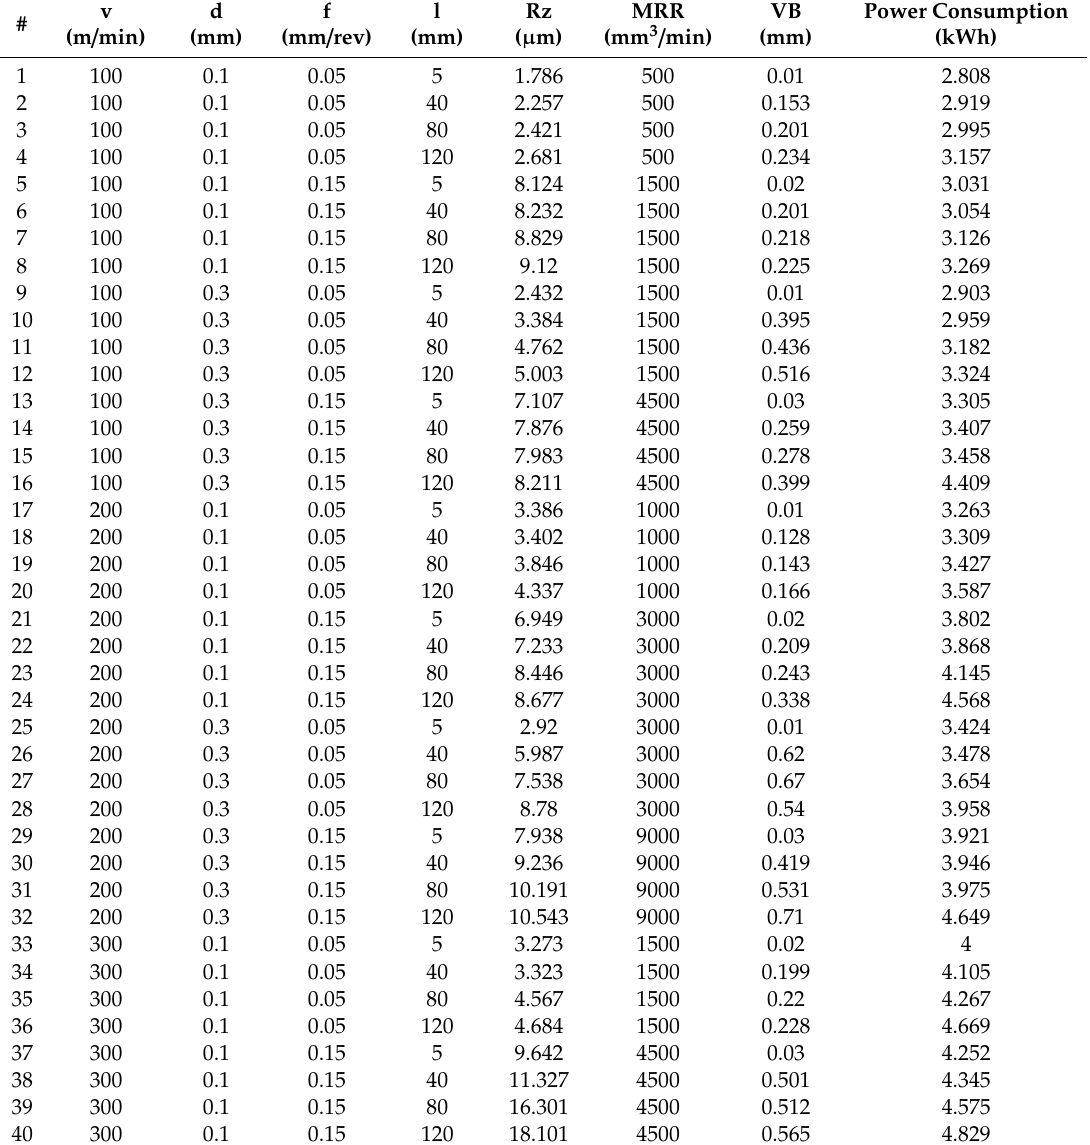
Table 3. Experimental results for the machining of